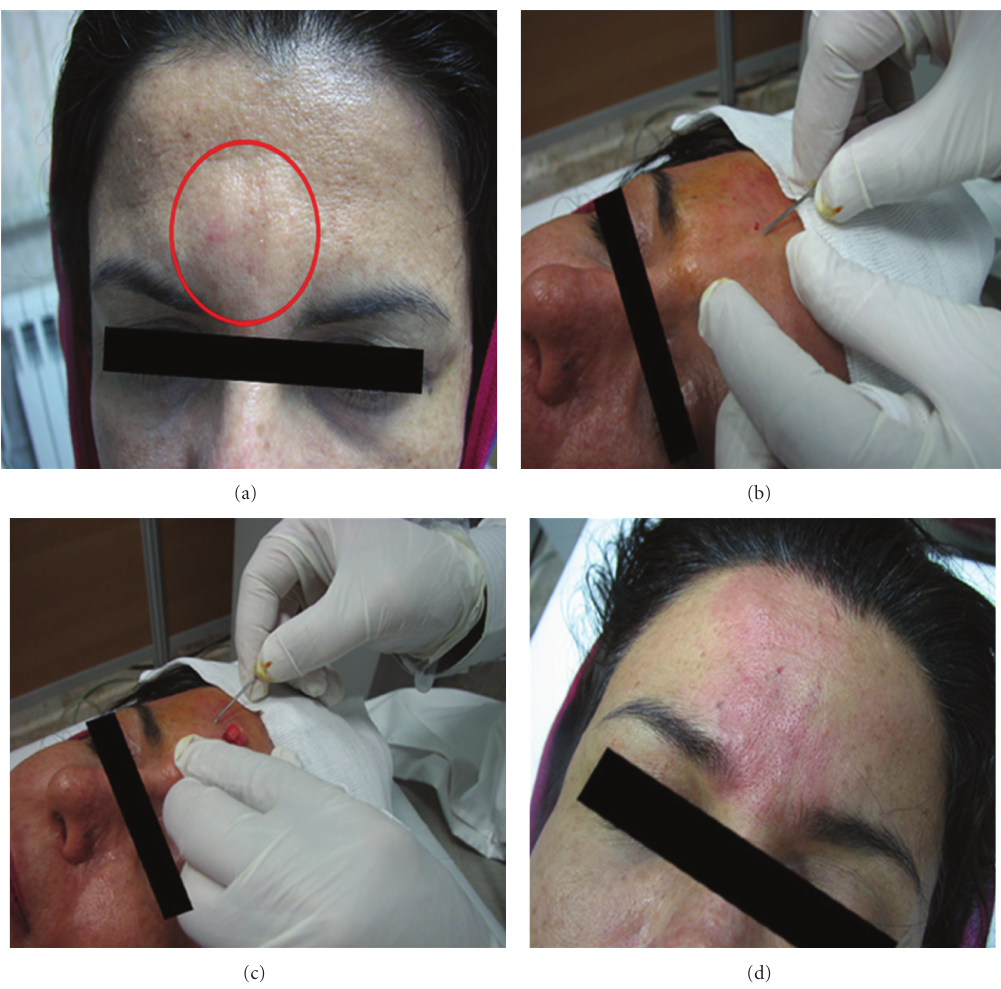
Figure 2: (a) Patient with delayed gel indurations in glabella area. (b) Using needle (gauge 16) induced hole and tunneling. (c) Squeezing or sliding pressure results in drainage of remaining of gel. (d) Complete exhaust